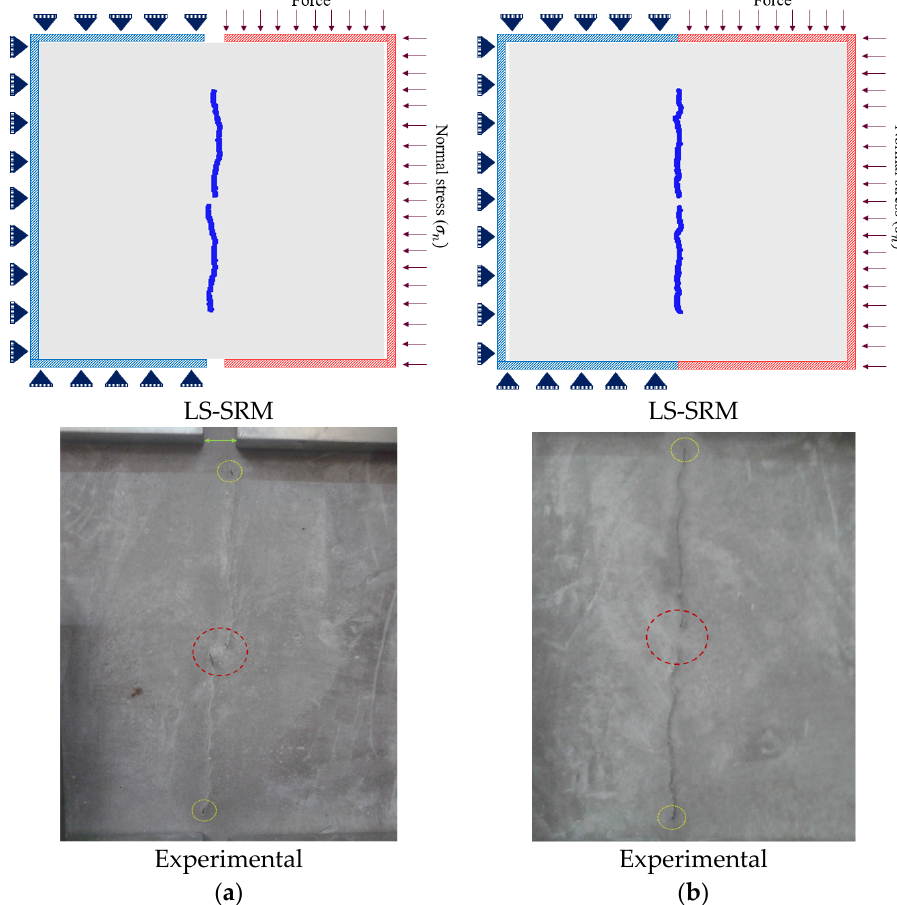
Figure 10. The geometry of direct shear specimens of ( a ) noncoplanar rock bridge specimens and ( b ) coplanar rock bridge specimens.